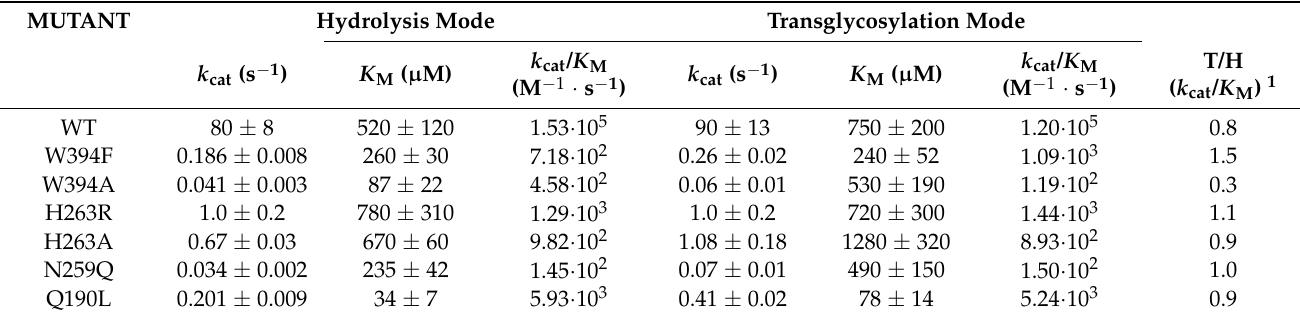
Table 4. Kinetic parameters (donor substrate) of LnbB-catalyzed hydrolysis and transglycosylation reactions. MUTANT Hydrolysis Mode Transglycosylation